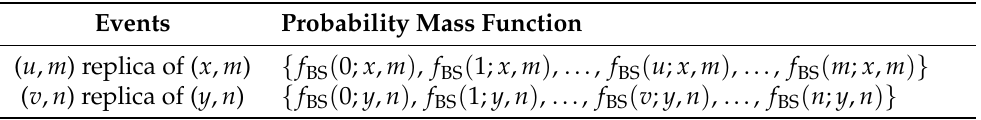
Table 1. Probability mass functions for the replica ( u , v , m , n ) of the 2 × 2 contingency ( x , y , m , n ). Events Probability Mass Function